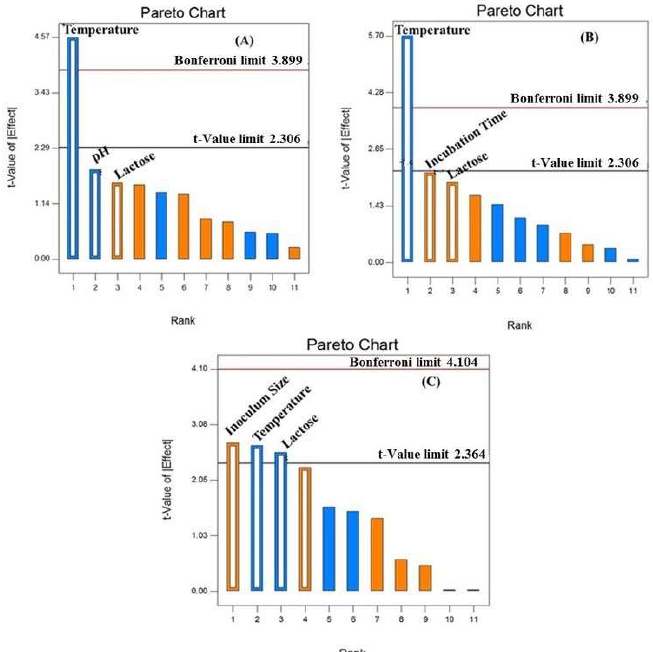
Figure 6. Pareto charts obtained from Plackett-Burman design for ( A ) agarase activity ( B ) amylase activity ( C ) xylanase activity.